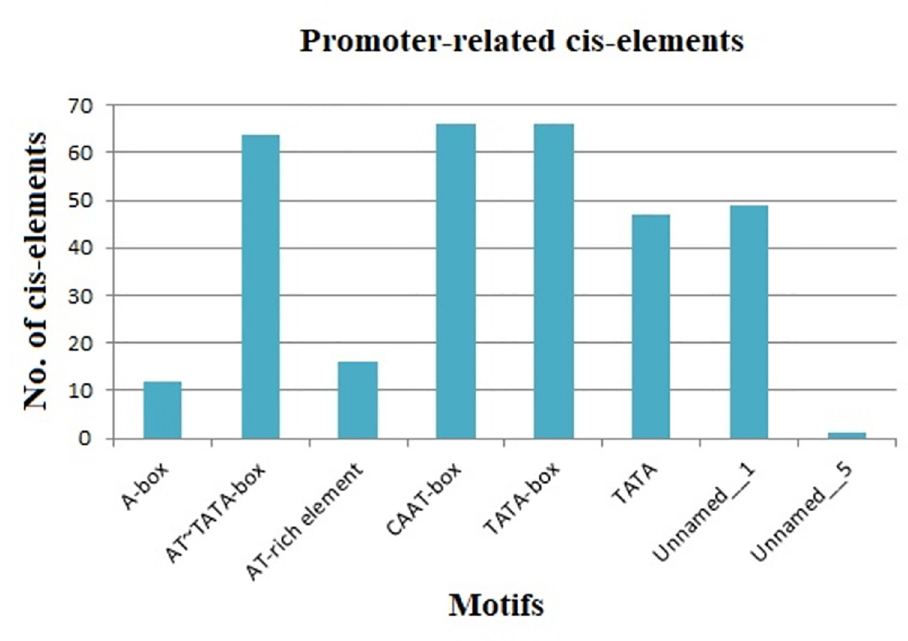
Fig 3. Graphical representation of promoter-related elements in StDREB genes identified using PlantCARE and NEW PLACE database. X-axis represented names of various motifs, whereas Y-axis represented the number of cis- elements in 66 StDREB